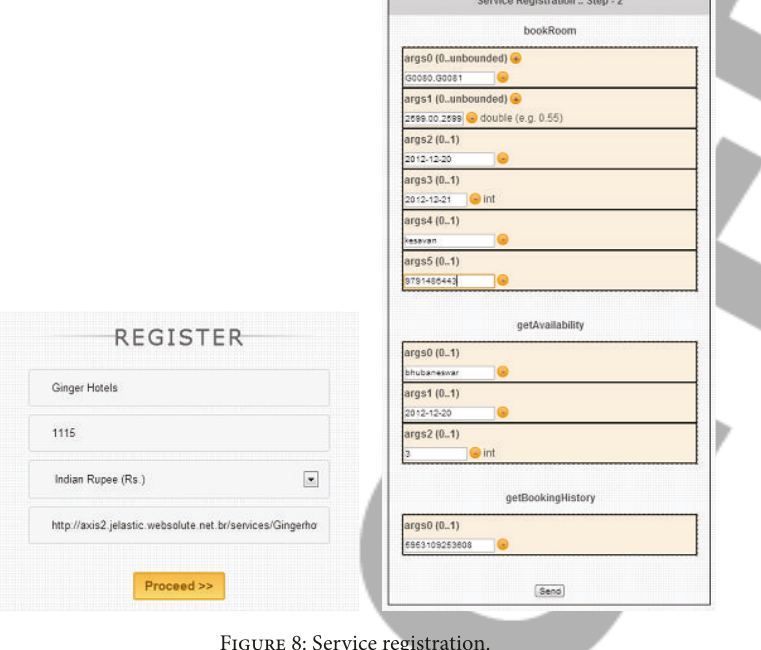
Figure 8: Service registration.